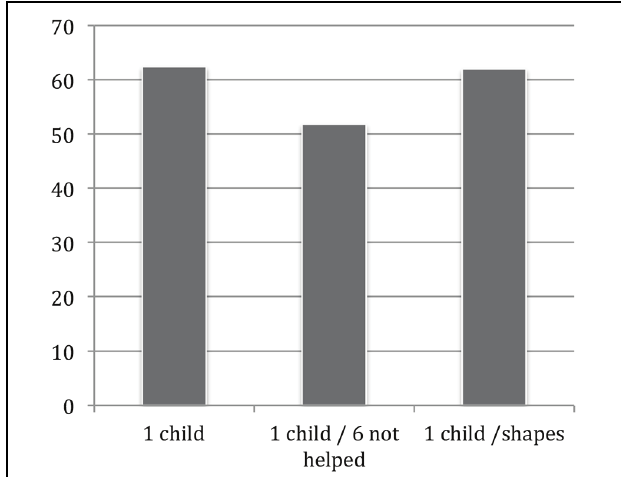
FIGURE 4 | Mean warm-glow ratings across the different conditions in the distractor